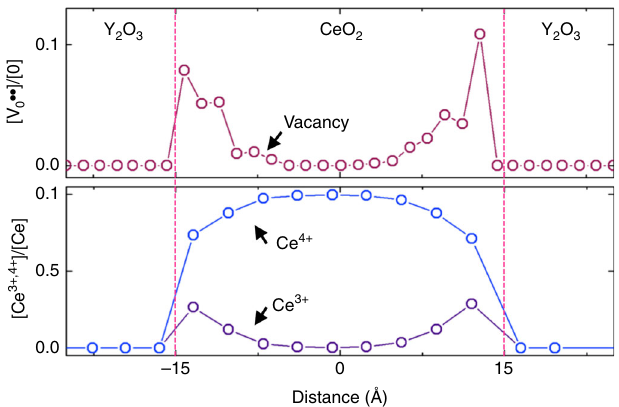
Fig. 4 Cation and oxygen vacancy distributions at the (111) CeO 2 /Y 2 O 3 interface. Distribution pro fi les of oxygen vacancy (top) and Ce 3 + , Ce 4 + (bottom) equilibrated at 700 °C in CeO 2 and Y 2 O 3 calculated by hybrid Monte Carlo (MC) and molecular dynamics (MD) simulations. The interfaces enrich Ce 3 + and oxygen vacancies simultaneously within CeO 2 . The concentration of oxygen vacancies can reach up to 10% at the interface, spanning over ~1